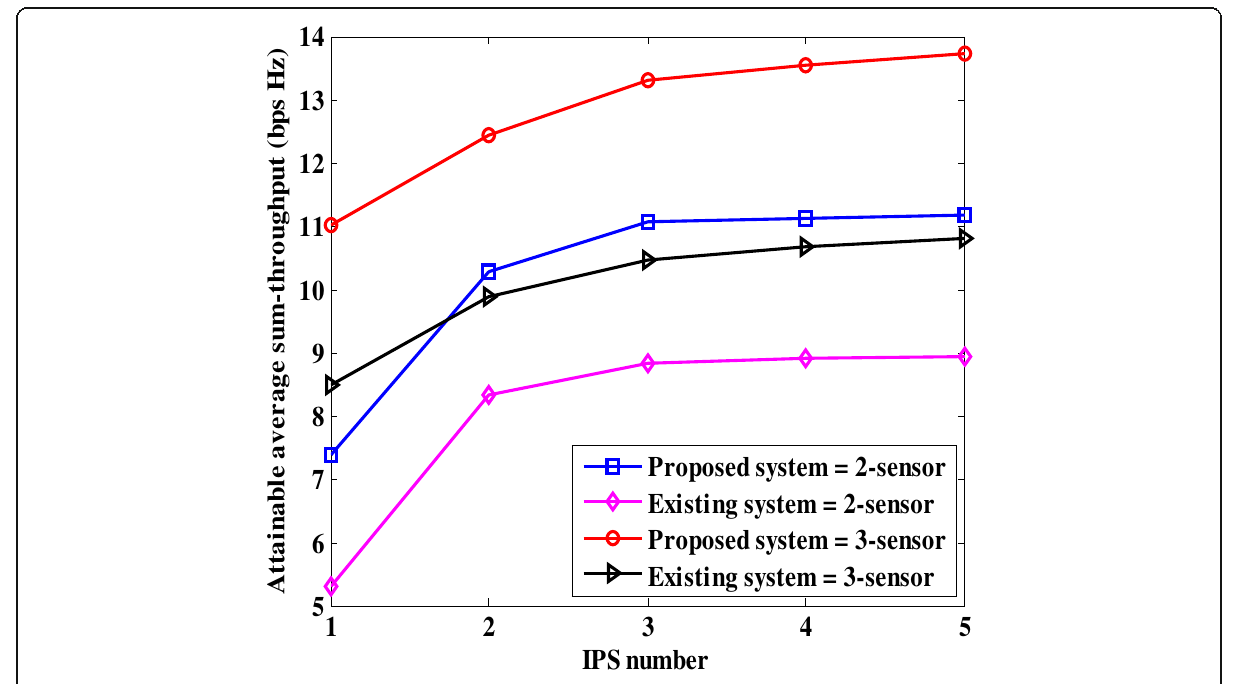
Fig. 6 Attainable average sum-throughput versus number of